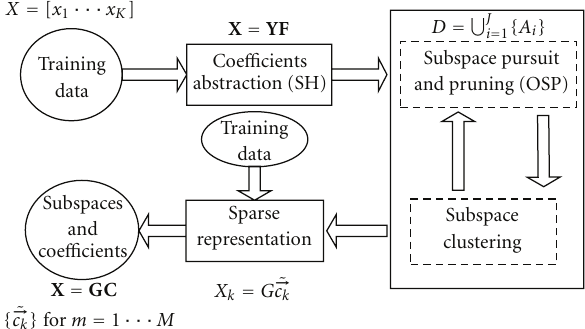
Figure 1: Flowchart of SRDS algorithm consists of three steps spec- ified in the solid rectangulars; ellipsoids denote data input and